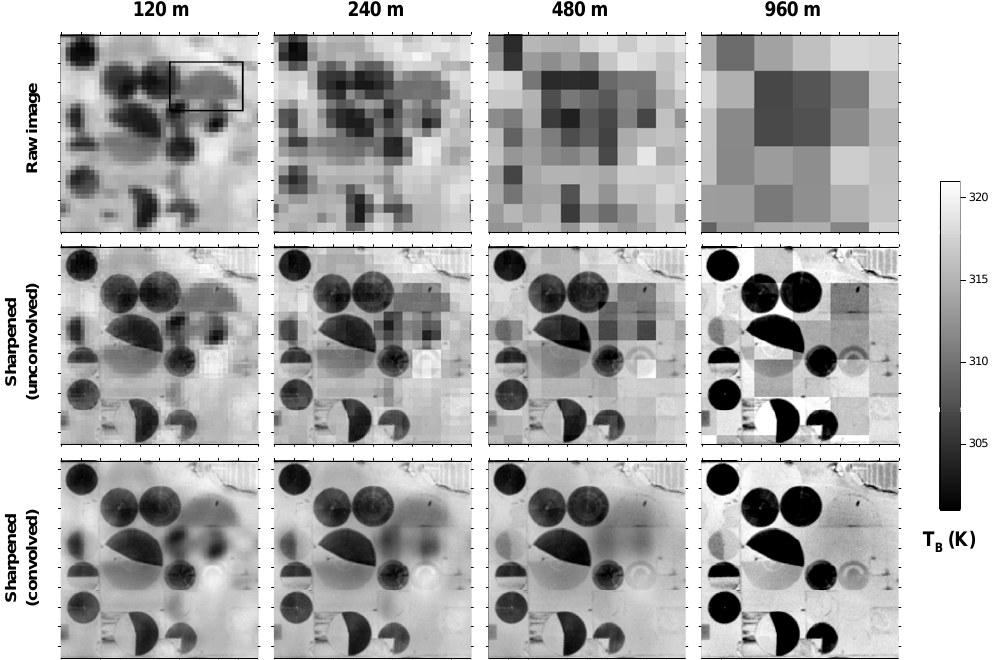
Fig. 3. Example of thermal sharpening applied to data aggregated from a Landsat 5 scene over an irrigated agricultural area in the Texas Panhandle. Top row shows TIR imagery at 120-m native resolution (left column) and aggregated to 240m, 480m, and 960m (right column), the latter approximating MODIS TIR resolution. These fields were sharpened to 30m resolution using Landsat-derived NDVI, using uncon- volved (middle row) and convolved (bottom row) residual fields. The box in the 120-m raw image (upper left) highlights a recently irrigated area with low vegetation cover, which disappears in the 960-m sharpened image (lower right), demonstrating limitations in the capabilities of the sharpening algorithm.